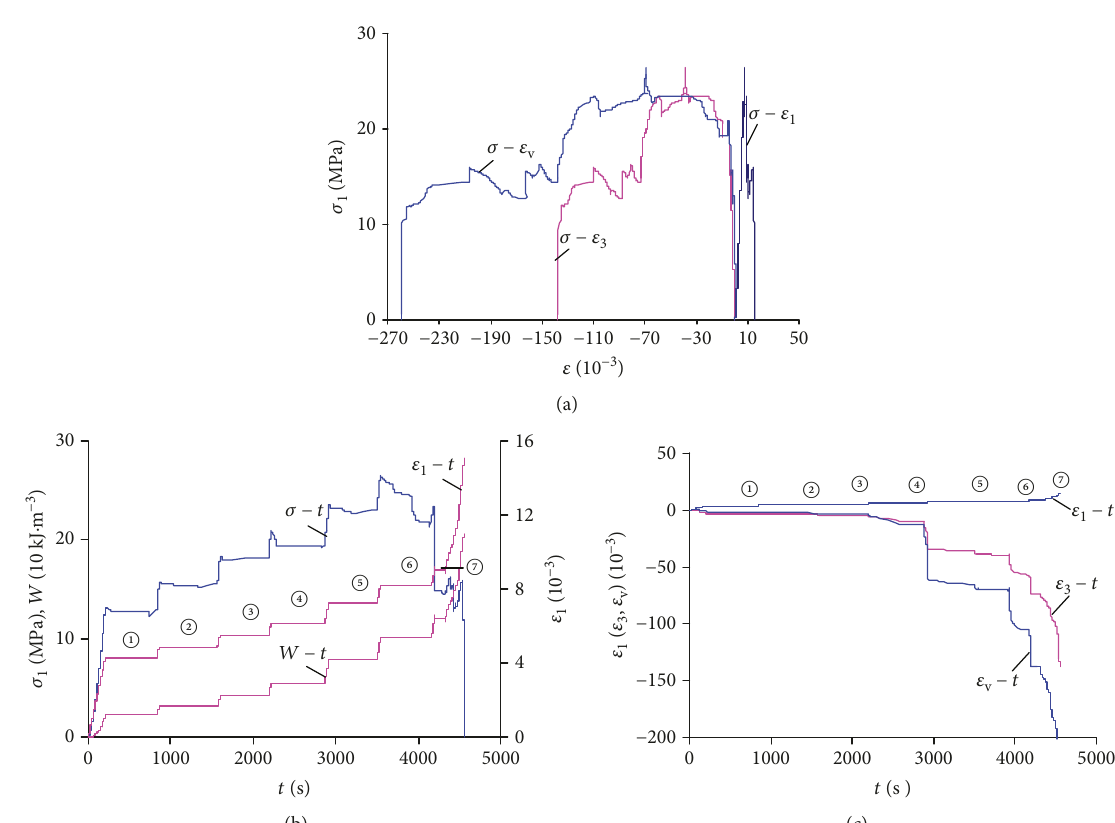
Figure 5: Complete stress (strain, energy) versus time curves for the uniaxial compression step relaxation of coal sample